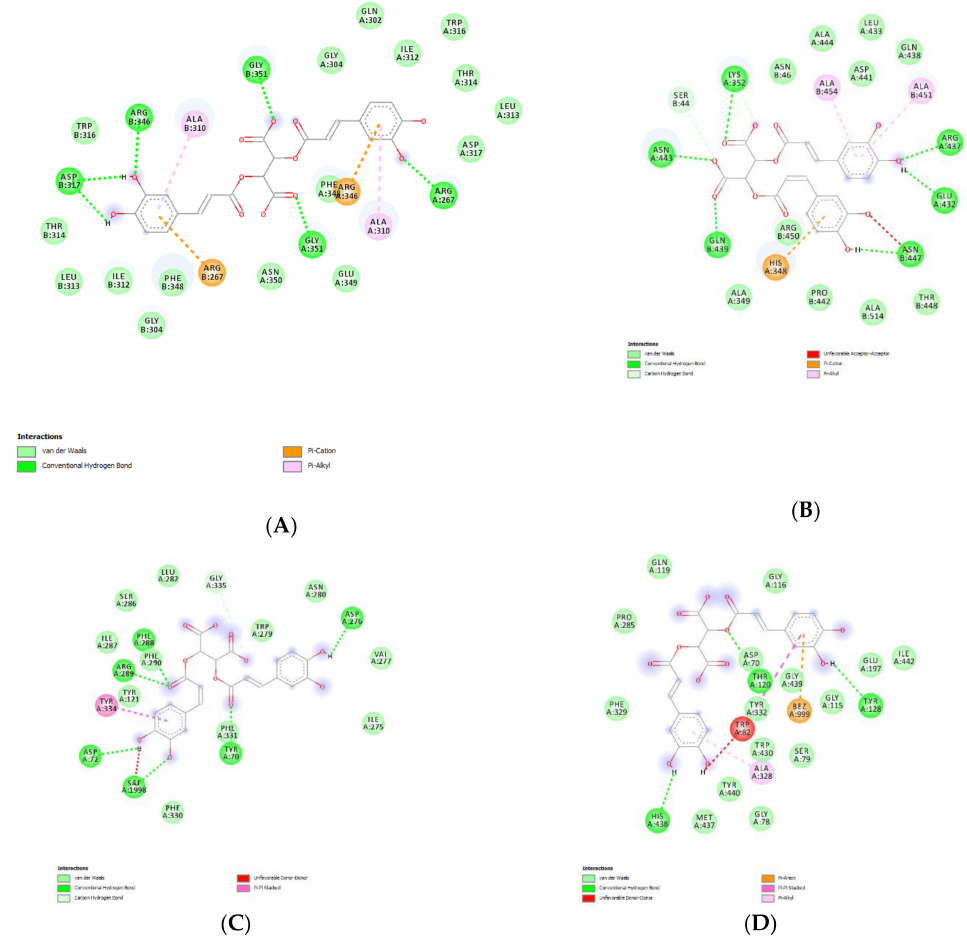
Figure 3. ( A ) Putative interactions between chicoric acid and α -amylase (PDB: 1XV8). Free energy of binding ( ∆ G) and affinity (Ki) are − 9.2 kcal/mol and 0.2 µ M, respectively. ( B ) Putative interactions between chicoric acid and α -glucosidase (PDB: 3WY1). Free energy of binding ( ∆ G) and affinity (Ki) are − 8.8 kcal/mol and 0.4 µ M, respectively. ( C ) Putative interactions between chicoric acid and AChE (PDB: 1GQR). Free energy of binding ( ∆ G) and affinity (Ki) are − 8.4 kcal/mol and 0.7 µ M, respectively. ( D ) Putative interactions between chicoric acid and BChE (PDB: 1GQR). Free energy of binding ( ∆ G) and affinity (Ki) are − 9.5 kcal/mol and 0.1 µ M,